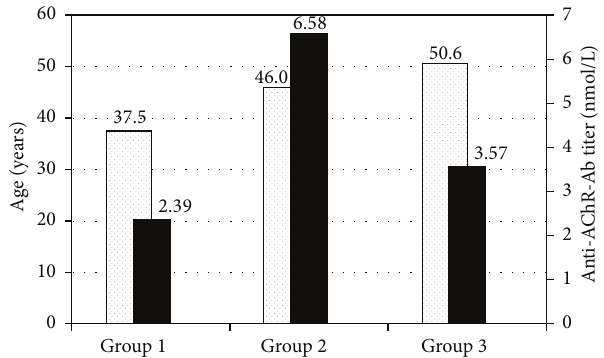
Figure 1: Age and anti-acetylcholine receptor antibody (anti-AChR- Ab) titer in the patients with abnormal anti-AChR-Ab.